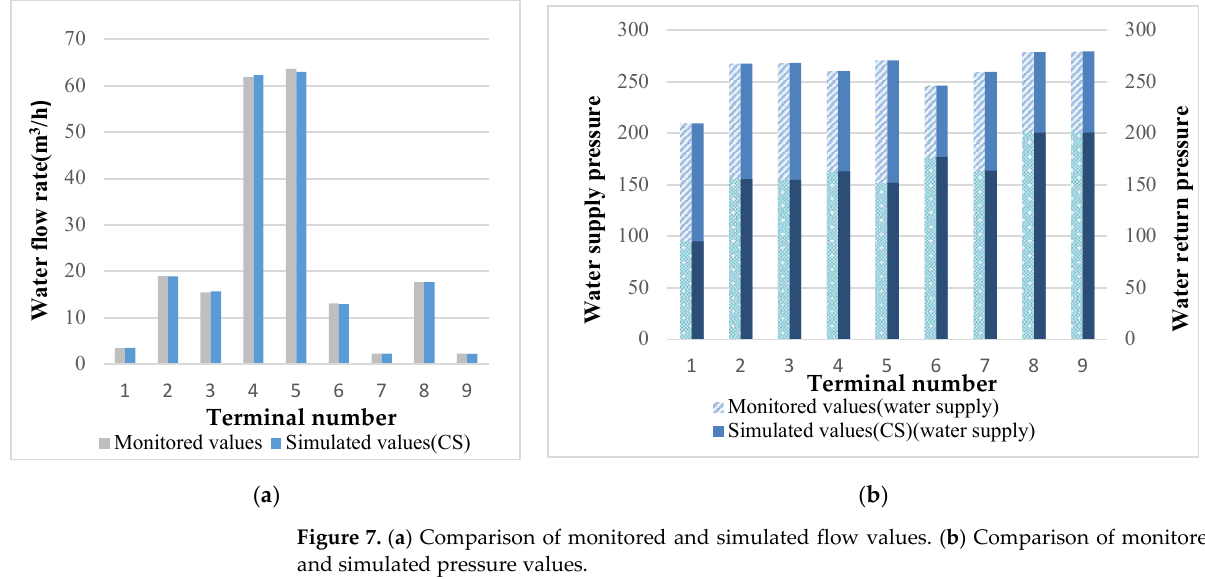
Figure 7. ( a ) Comparison of monitored and simulated flow values. ( b ) Comparison of monitored and simulated pressure values.